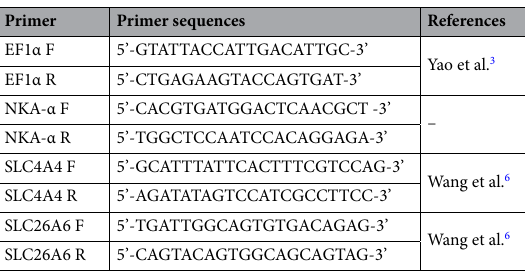
Table 1. Nucleotide sequences of the primers used for